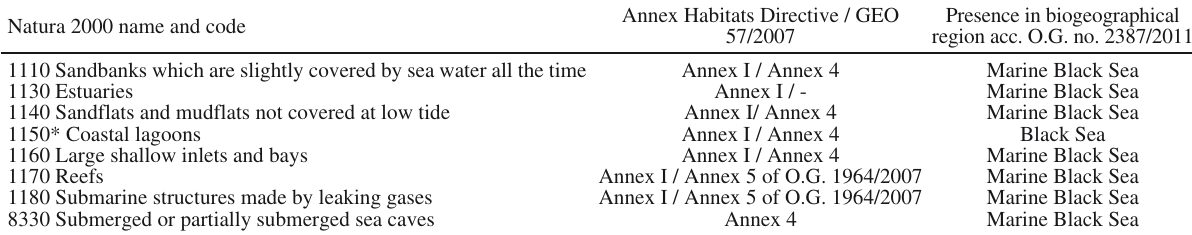
Table 2. – Marine habitats protected under Habitats